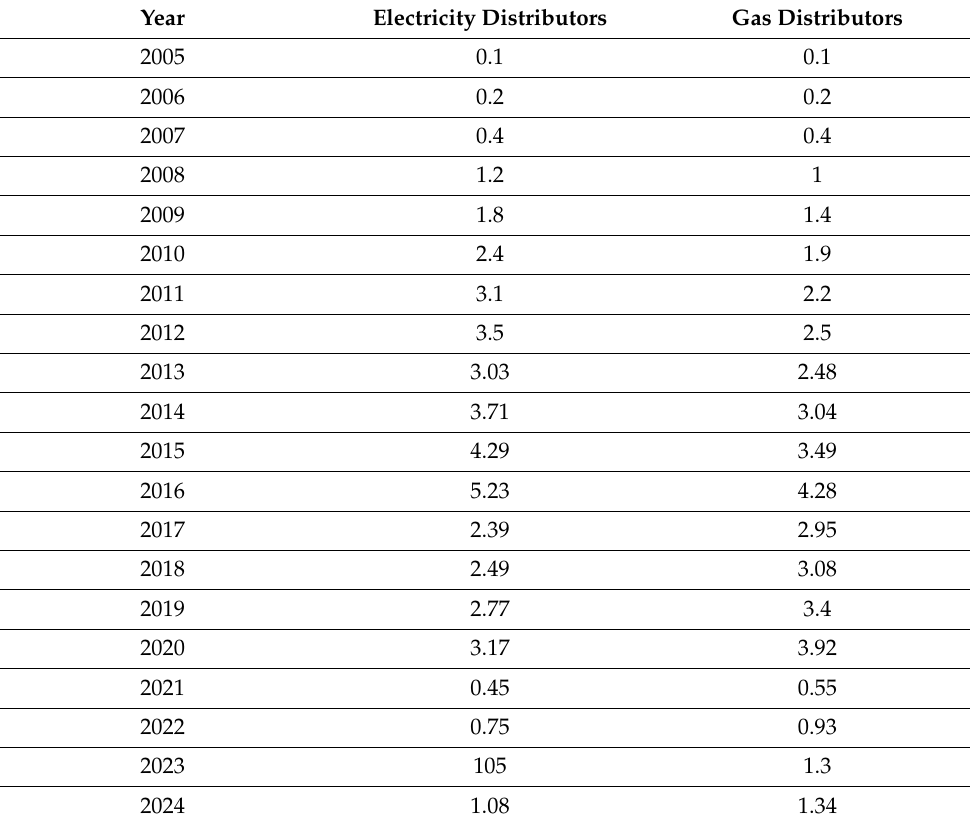
Figure 1. Overview of EEOS distribution across key EU countries. Source: own elaboration. Table 2. Target for the Italian White Certificate